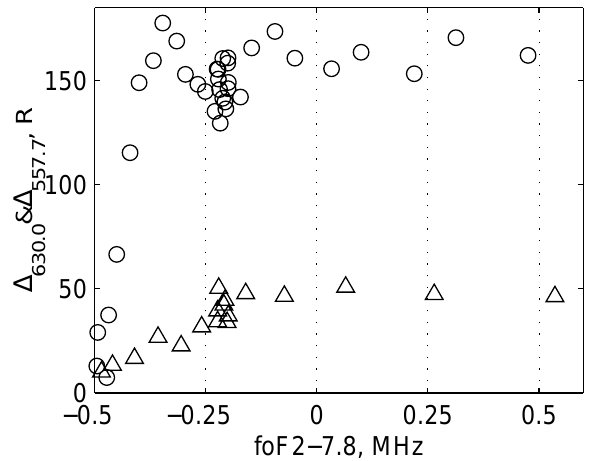
Fig. 5. Variation of the HF-induced red- (circles) and green-line (tri- angles) intensities with fo F2 during the long pulse shown in Fig. 4.